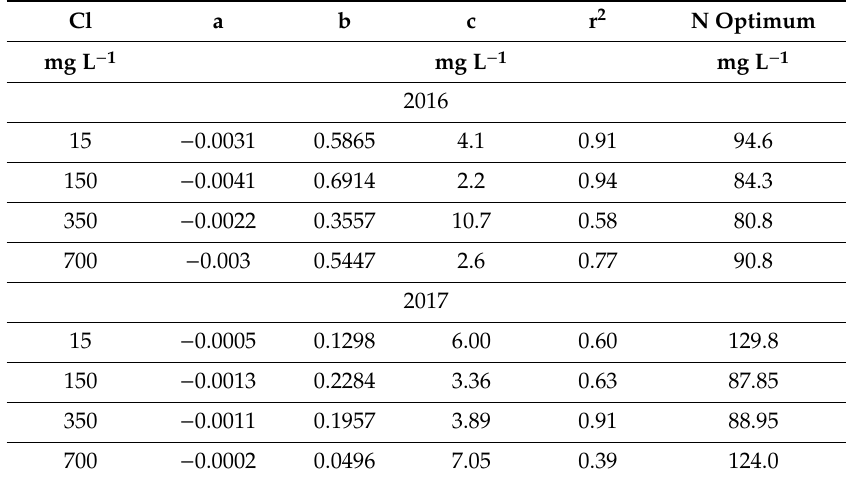
Table3. Best fit parametersof Equation (1) for bestfit curves of Figure 1. r 2 —coe ffi cient of